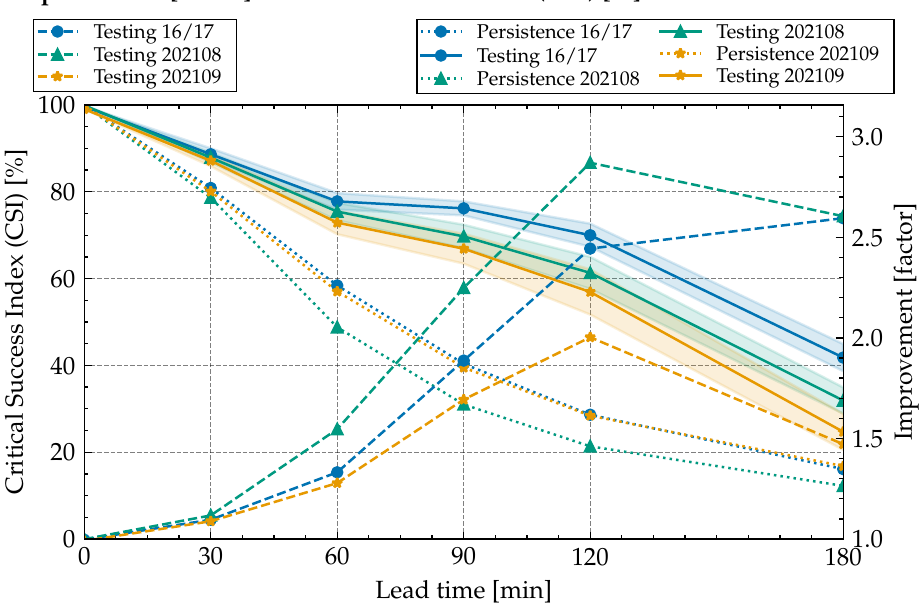
Figure 4. Improvement factor (right y -axis) and CSI (left y -axis) over lead time: Performance measures using CSI for a search radius of 30.61 km of our method for various data sets. All lines showing the improvement factor start at the bottom-left, and all lines showing the CSI start at the